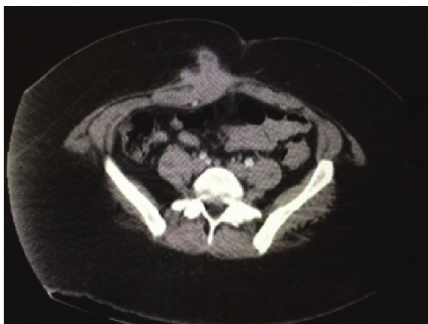
Figure4:Desmoidtumorwithirregularinfiltrationofblandspindle cells between skeletal muscle cells.